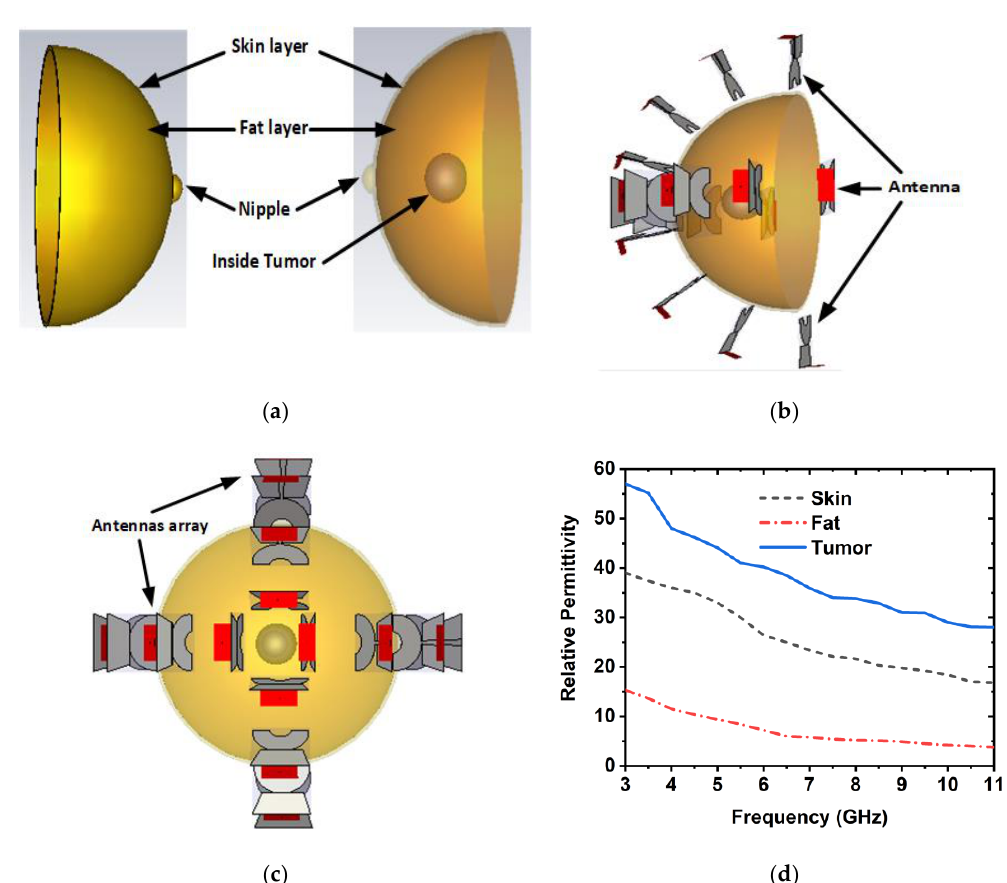
Table 3. The dielectric properties of the human breast tissues with tumor at 3.00 GHz frequency.